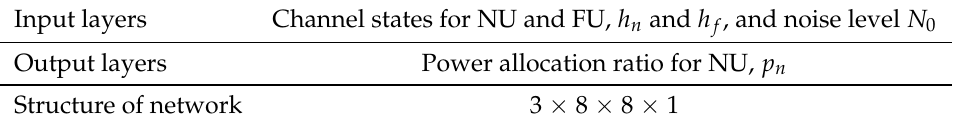
Table 2. Proposed MLP model